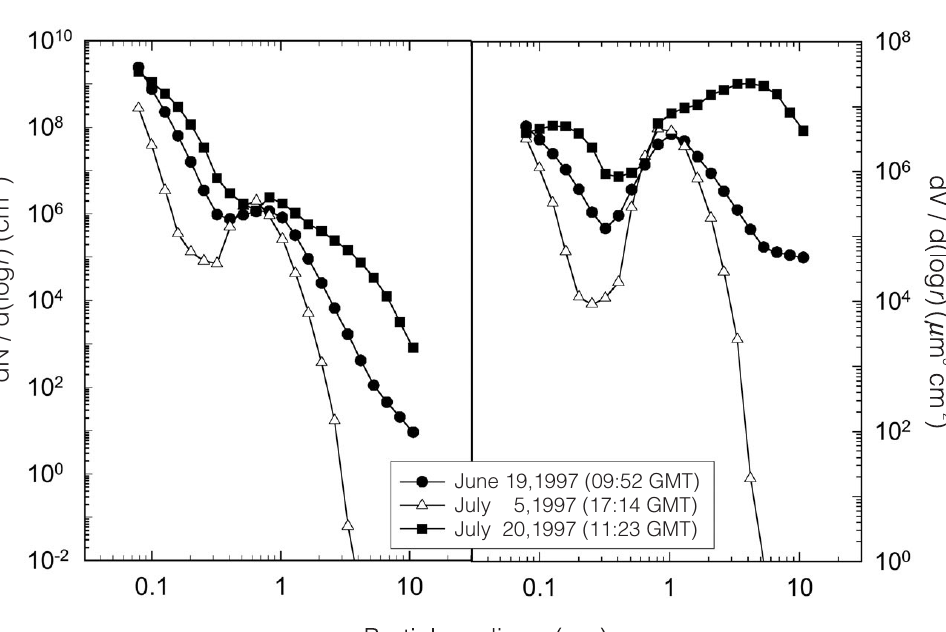
Fig. 2. Size-distribution curves of the columnar total particle number N ( left ) and columnar total particle volume V ( right ), found by analysing the three spectral series shown in fi g. 1 with the King (1982) inverse